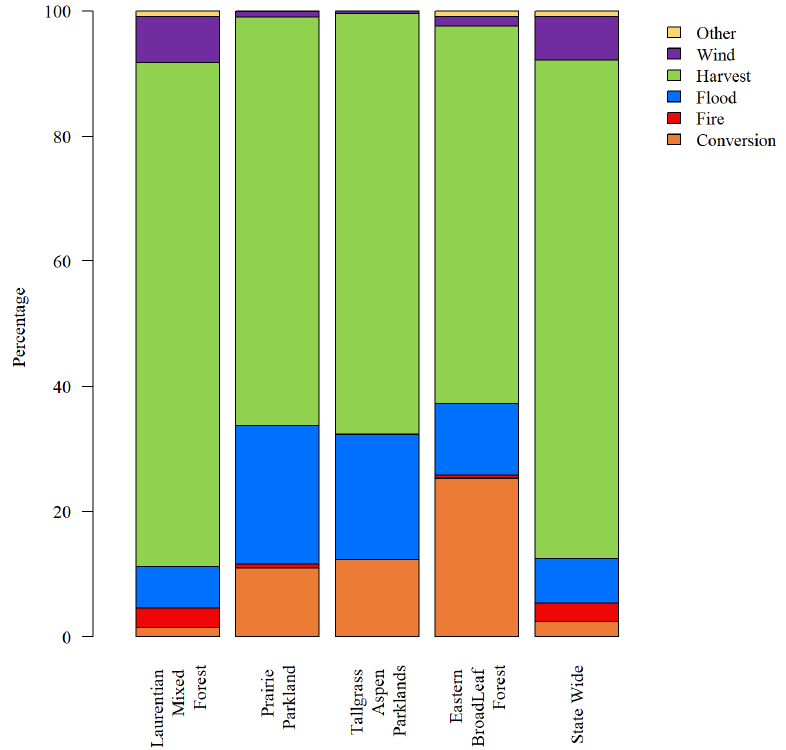
Figure 3. Proportion of area for the period of 1974–2018 by agent classes within Minnesota ecological regions.